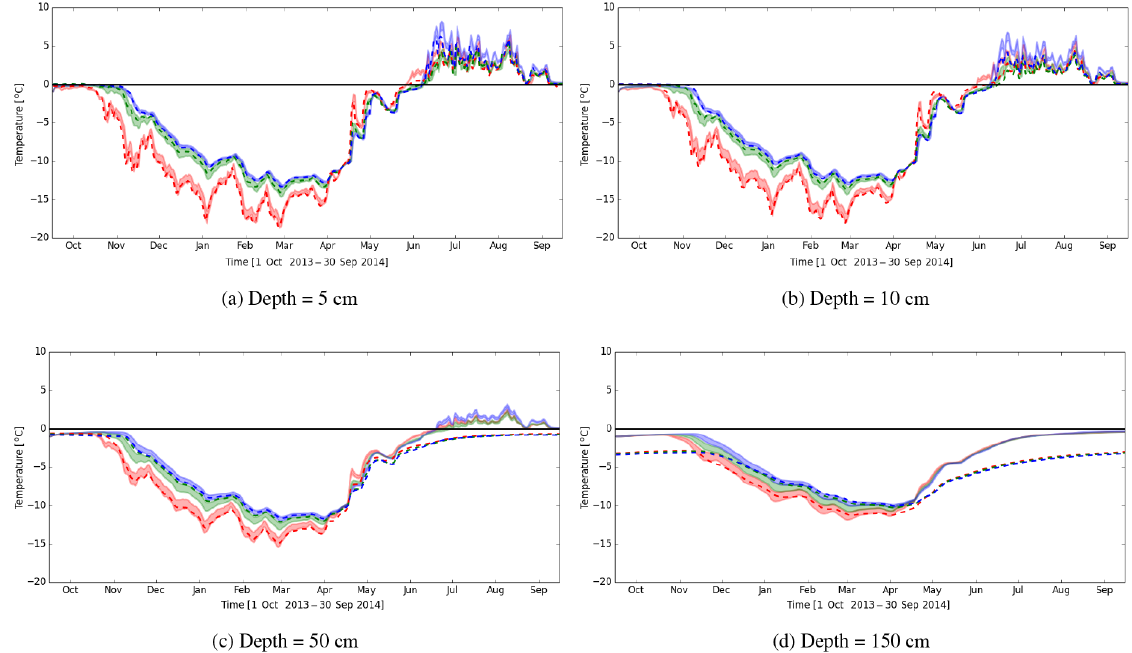
Figure 8. Simulated vs. observed soil temperatures at Site B at depths 5, 10, 50 and 150cm show bias in the model in deeper soil and during the warm summer season. Dotted lines represent observed data at center (in red), rim (green) and trough (blue) locations, while shaded curves show mean ± standard deviation of simulated daily soil temperatures across the domain.